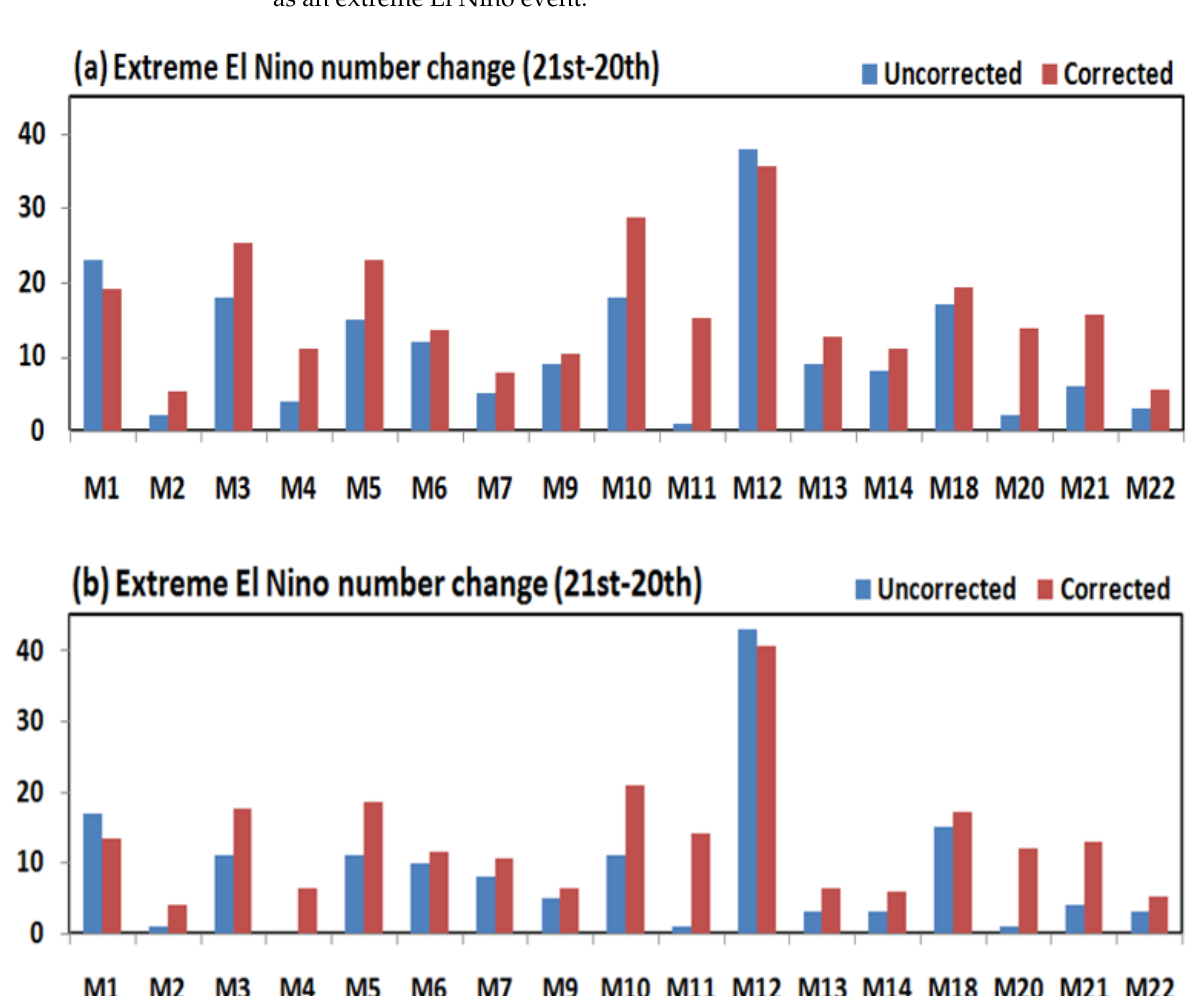
Figure 11. Uncorrected versus corrected increases in extreme El Niño occurrences between the 21st and 20th centuries in CMIP5 models. An extreme El Niño event in ( a ) was identified when the Niño3 DJF precipitation was over 5 mm/day. ( b ) Same as ( a ), but an extreme El Niño event was identified when the Niño3 DJF precipitation was over 6 mm/day.